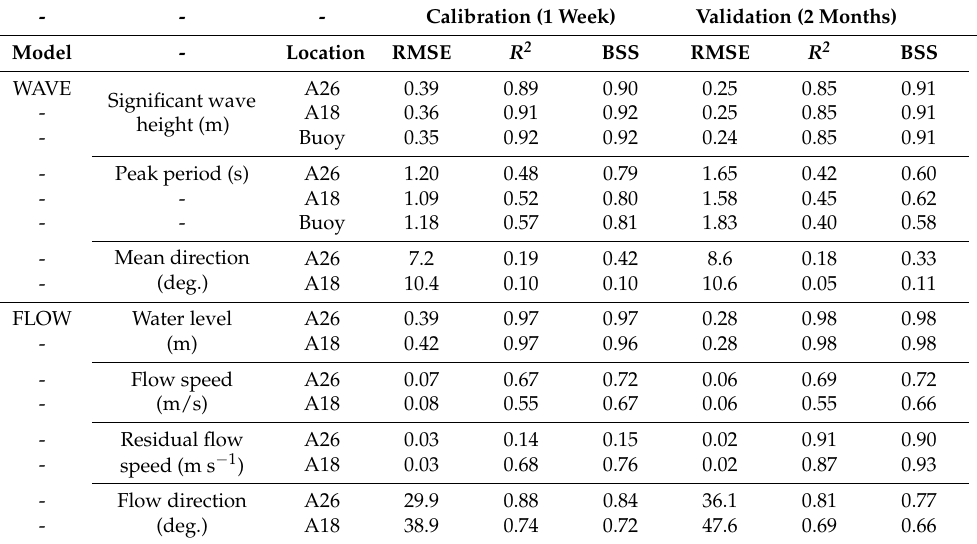
Table 3. Model calibration and